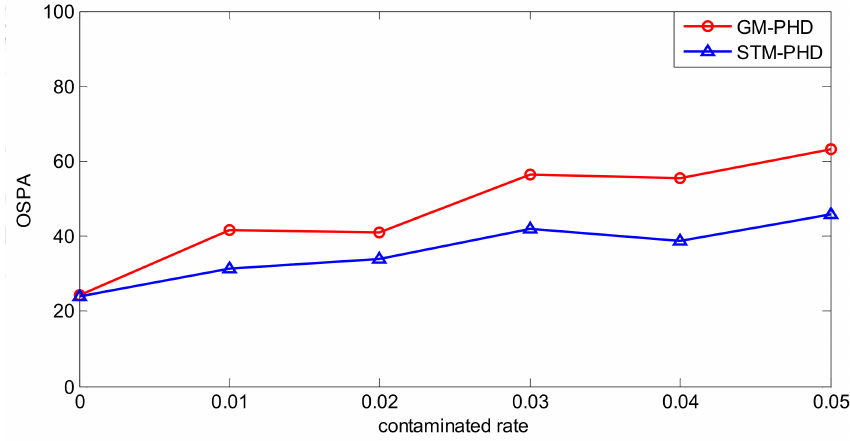
Figure 6. Comparison of OSPA distance of two filters with different contaminated